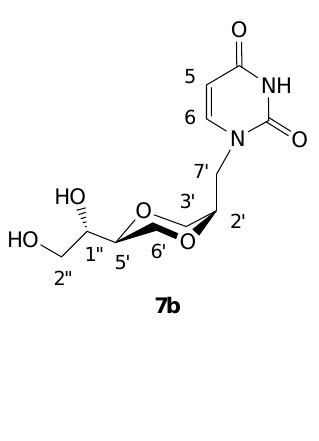
Figure 7. Structure 7b